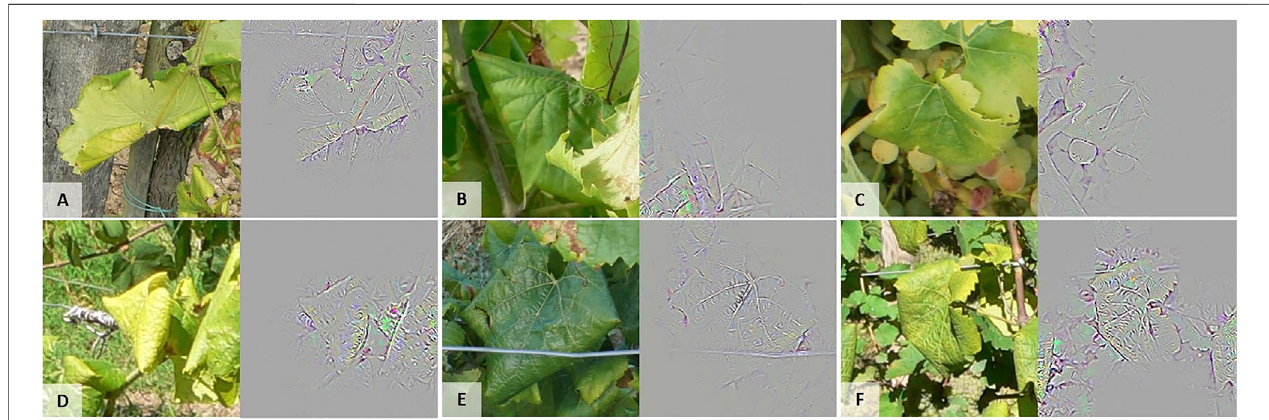
FIGURE 11 | Illustration of irrelevant features from GG-CAM that are used by the model to predict the Flavescence dorée (FD) class. (A) Trellising wire, petioles, canes,soil androlledshapes, (B) Canes, (C) Canes andgrapes, (D) Trellising wireandtriangular shadowshape, (E) Trellising wireandtriangular shadowshape, and (F) Trellising wire and